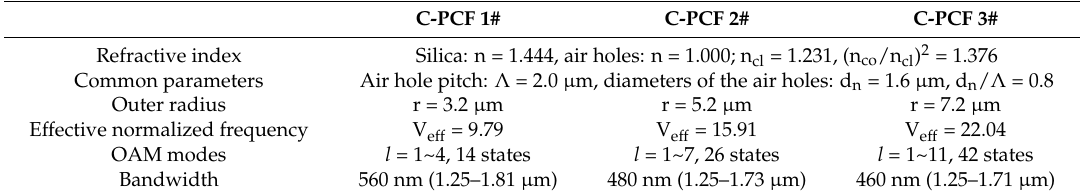
Table 1. Structure parameters of C-PCF family and orbital angular momentum (OAM) modes supported.